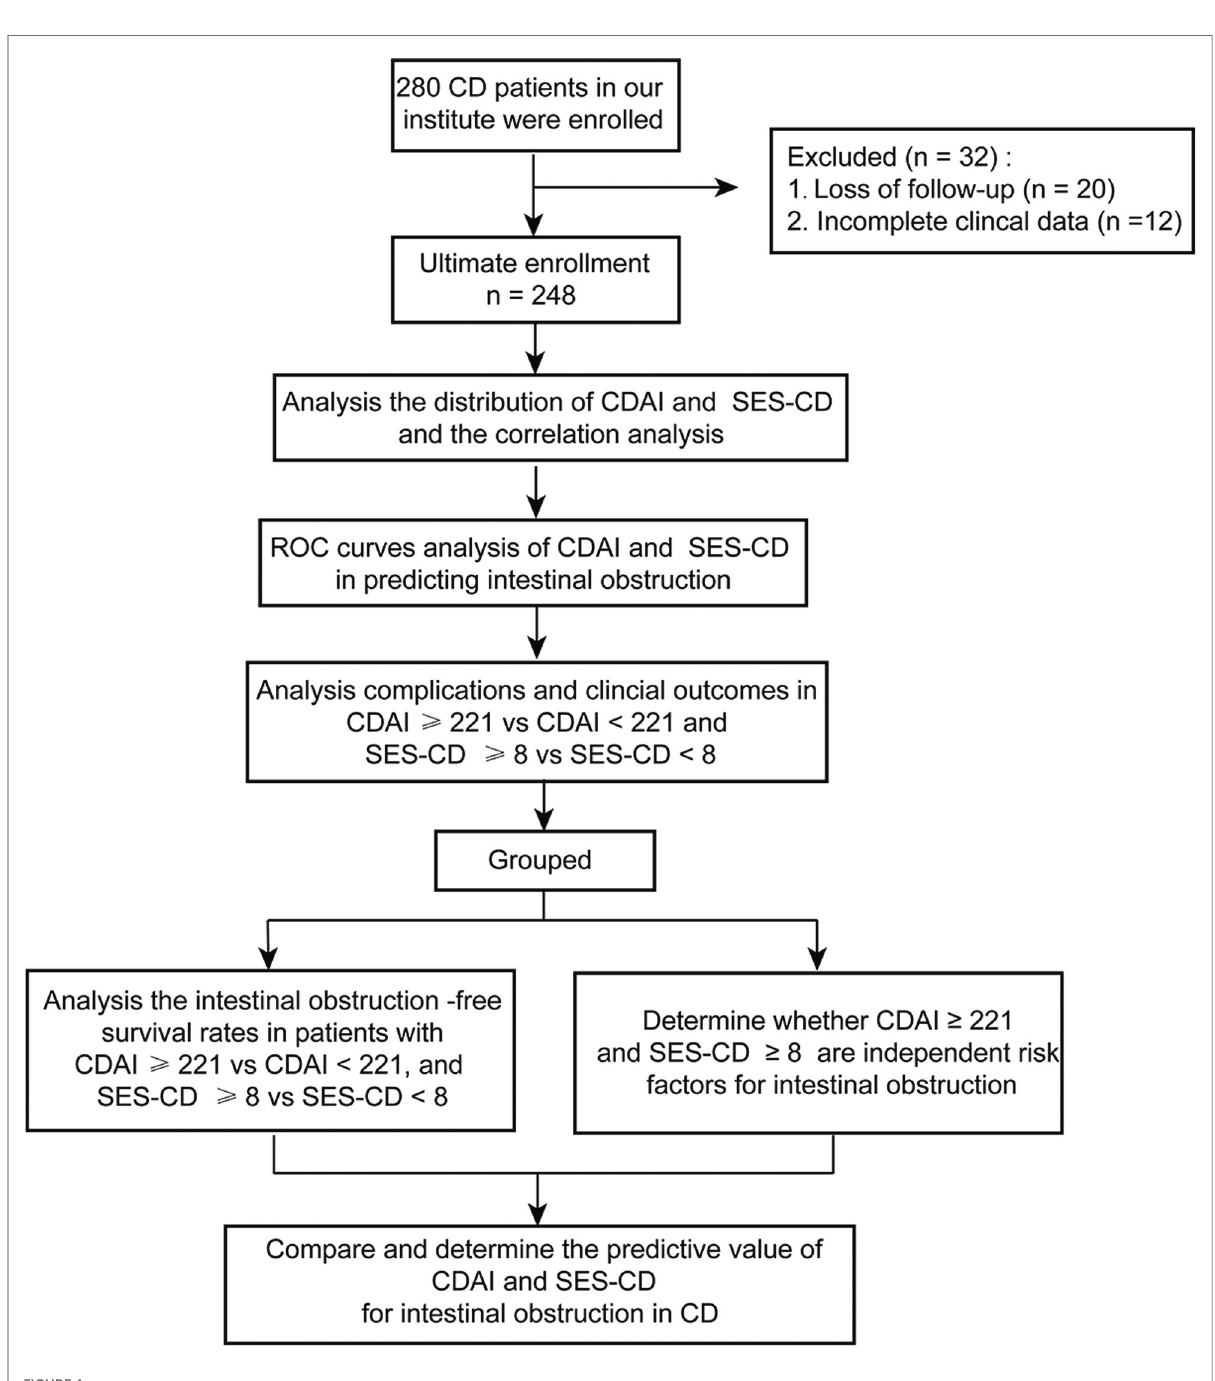
FIGURE 1 Schematic fl ow diagram of the present